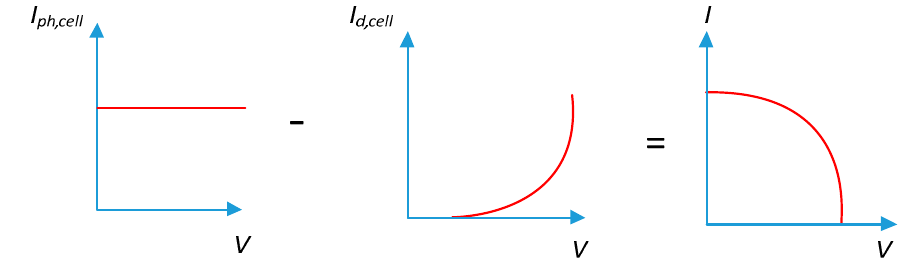
Figure 4. The equivalent circuit of photovoltaic cell.